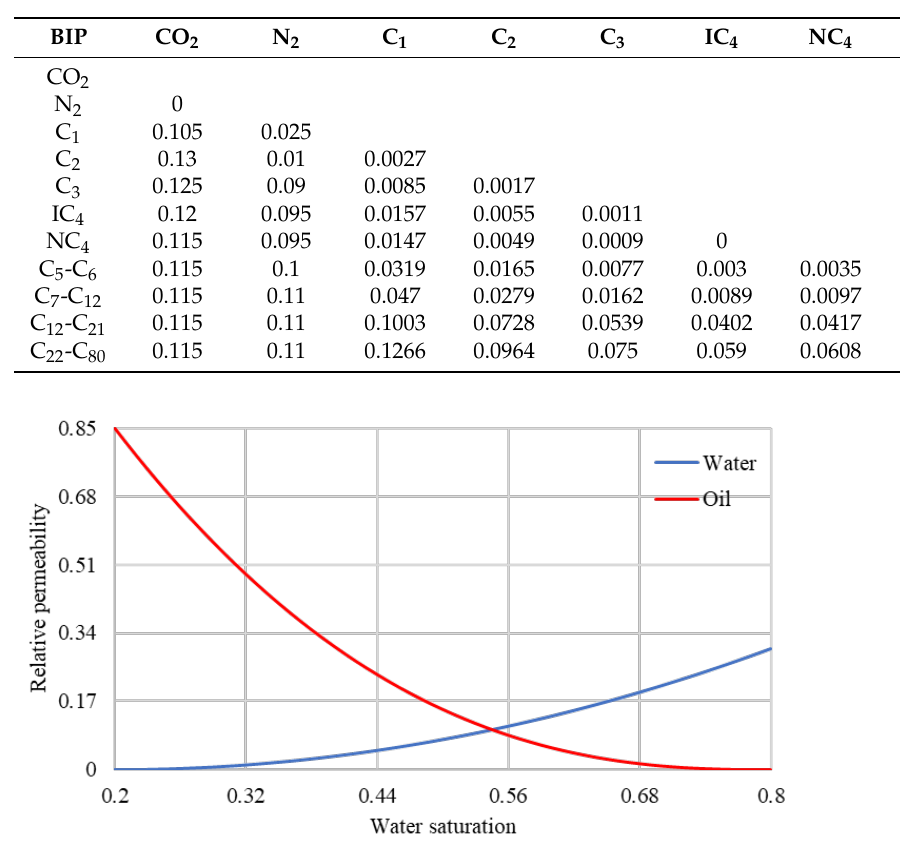
Table 4. Binary interaction parameters of the reservoir hydrocarbon fluid [38].